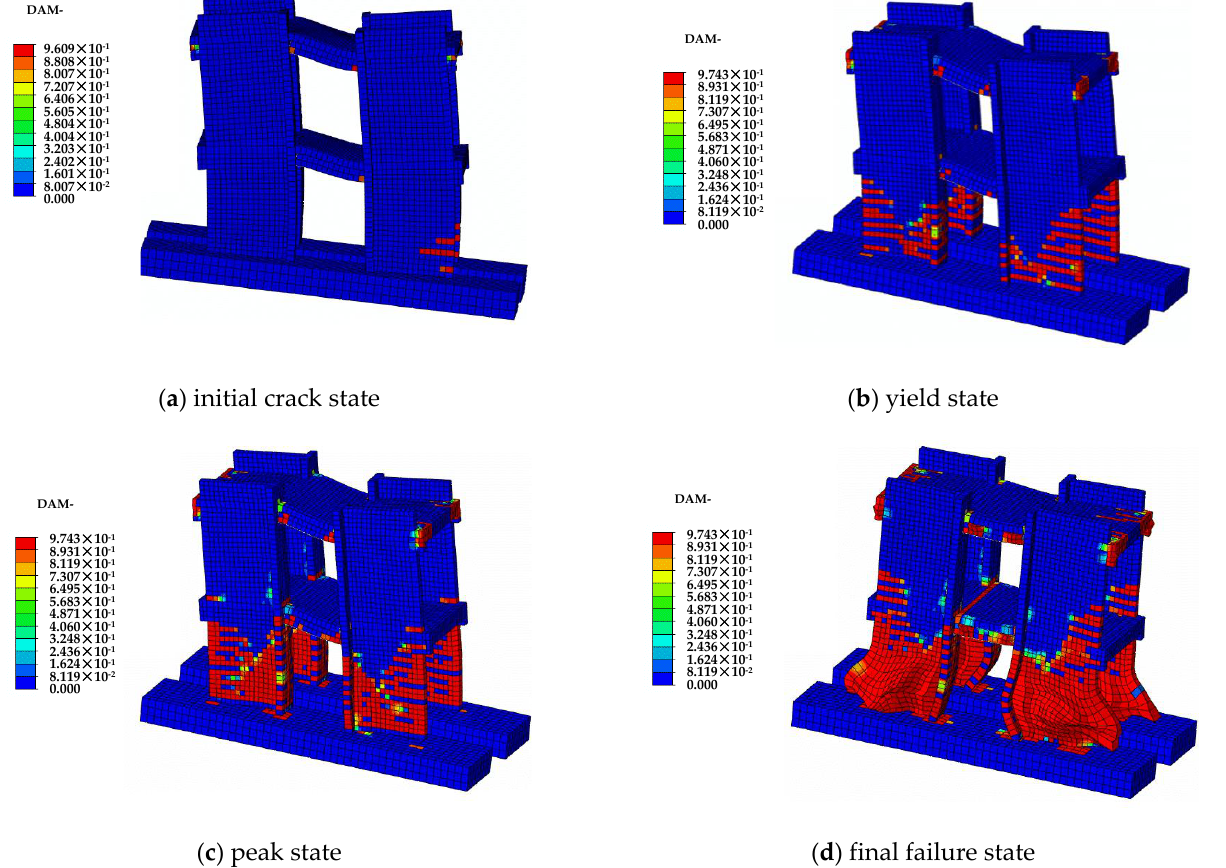
Figure 14. Crack distribution of the prefabricated ECC/RC combined shear wall.